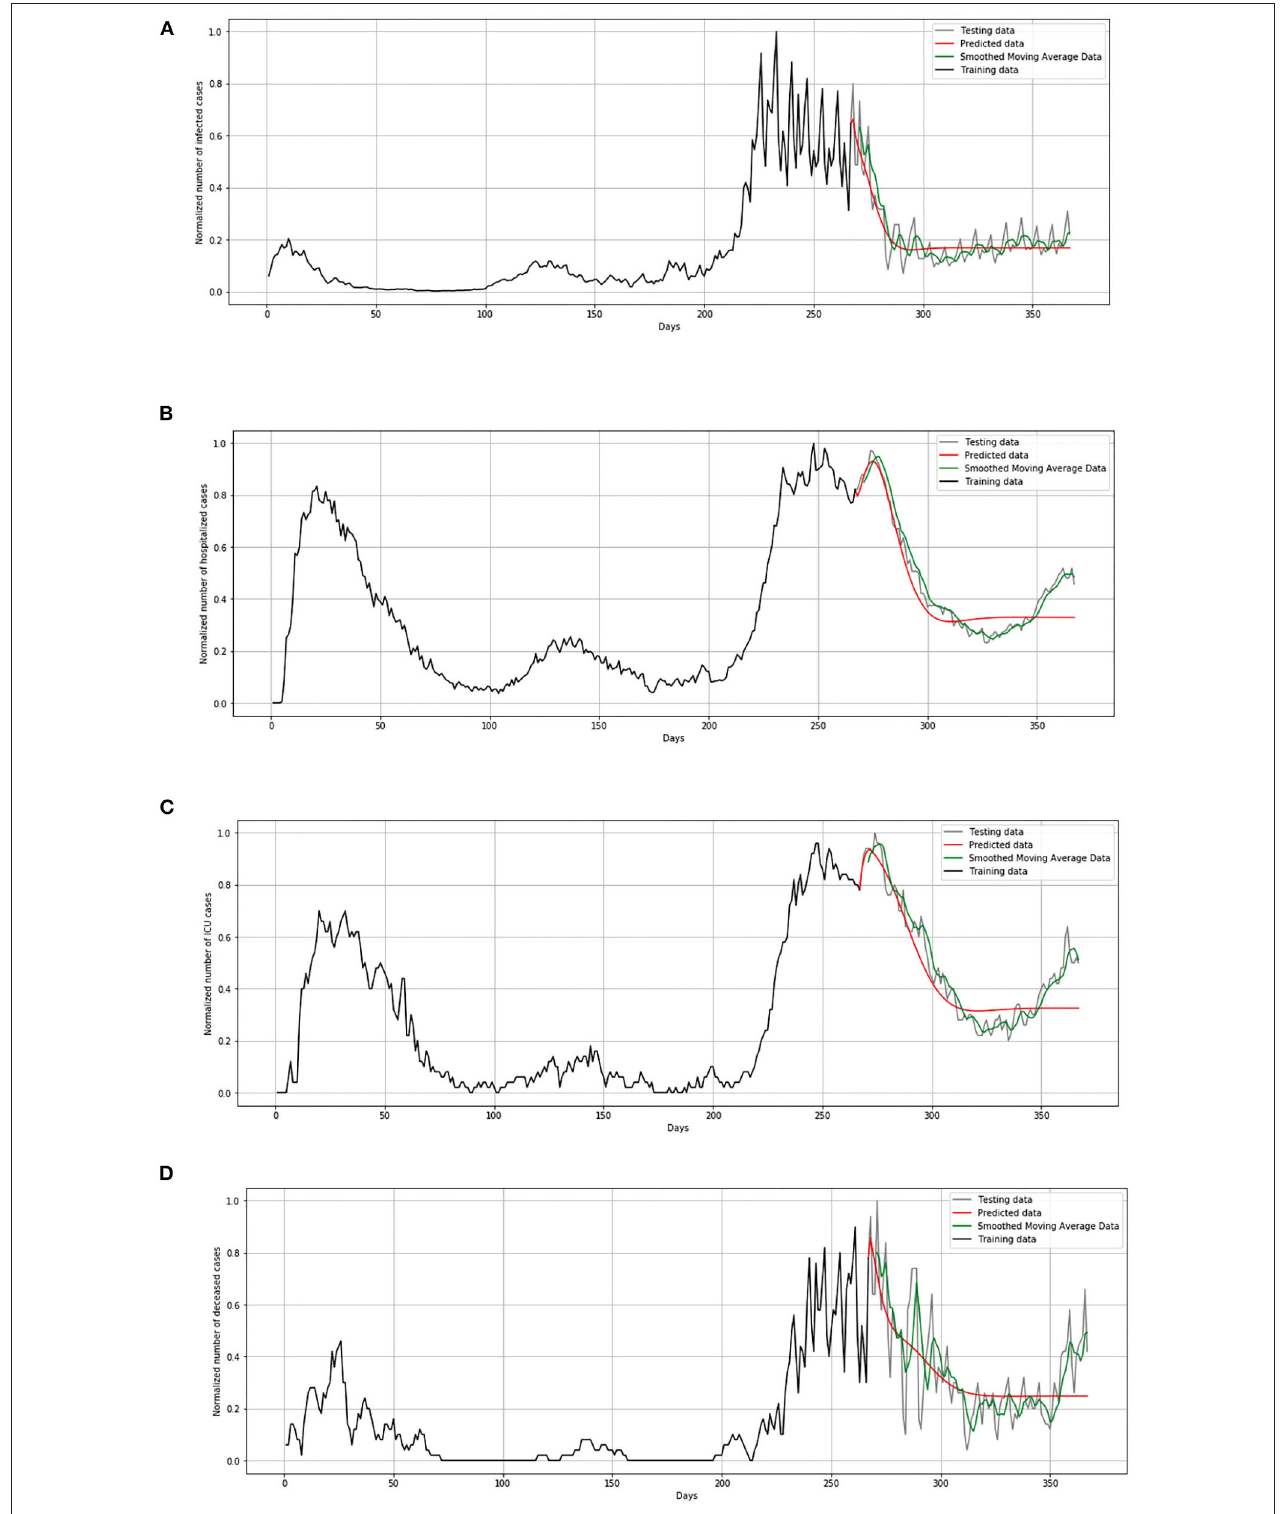
FIGURE 14 | Comparison of real and simulated values for Luxembourg: (A) number of infected cases, (B) number of hospitalized cases, (C) number of ICU cases, (D) number of deceased cases.